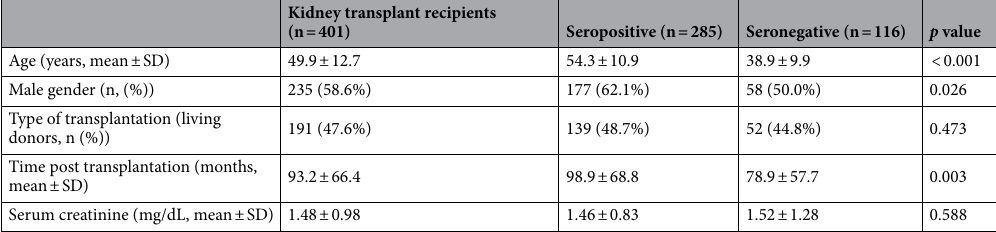
Table 1. Baseline characteristics of eligible kidney transplant recipients.